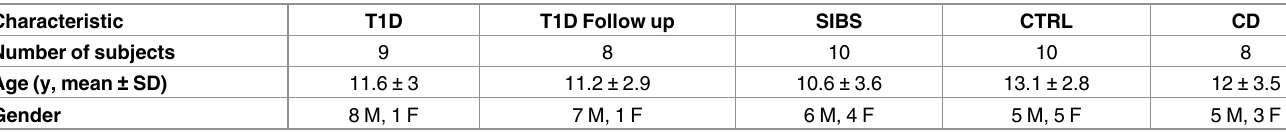
Table 1. Demographic